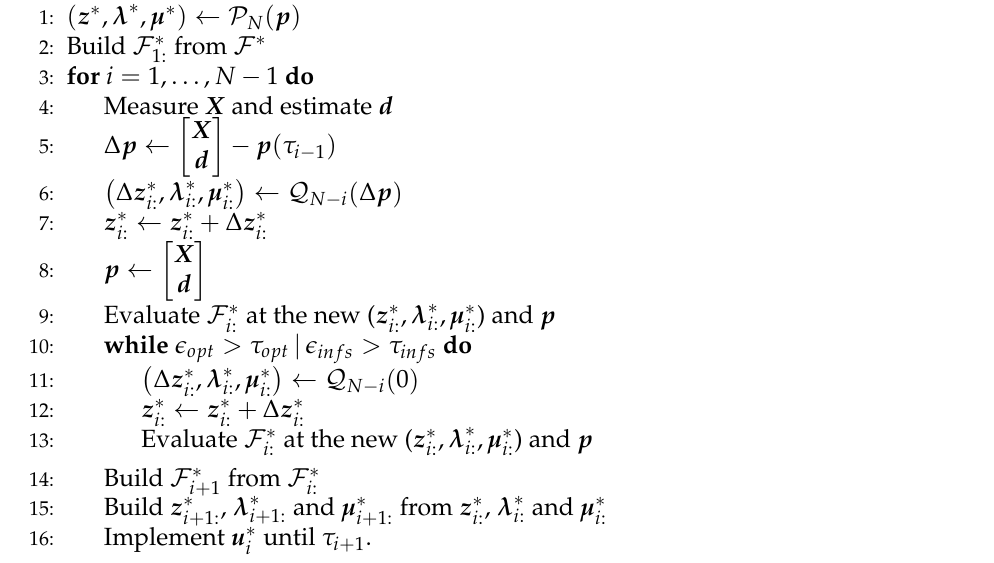
Algorithm 2 Working Principle of the Sensitivity-Based NMPC (SbNMPC)